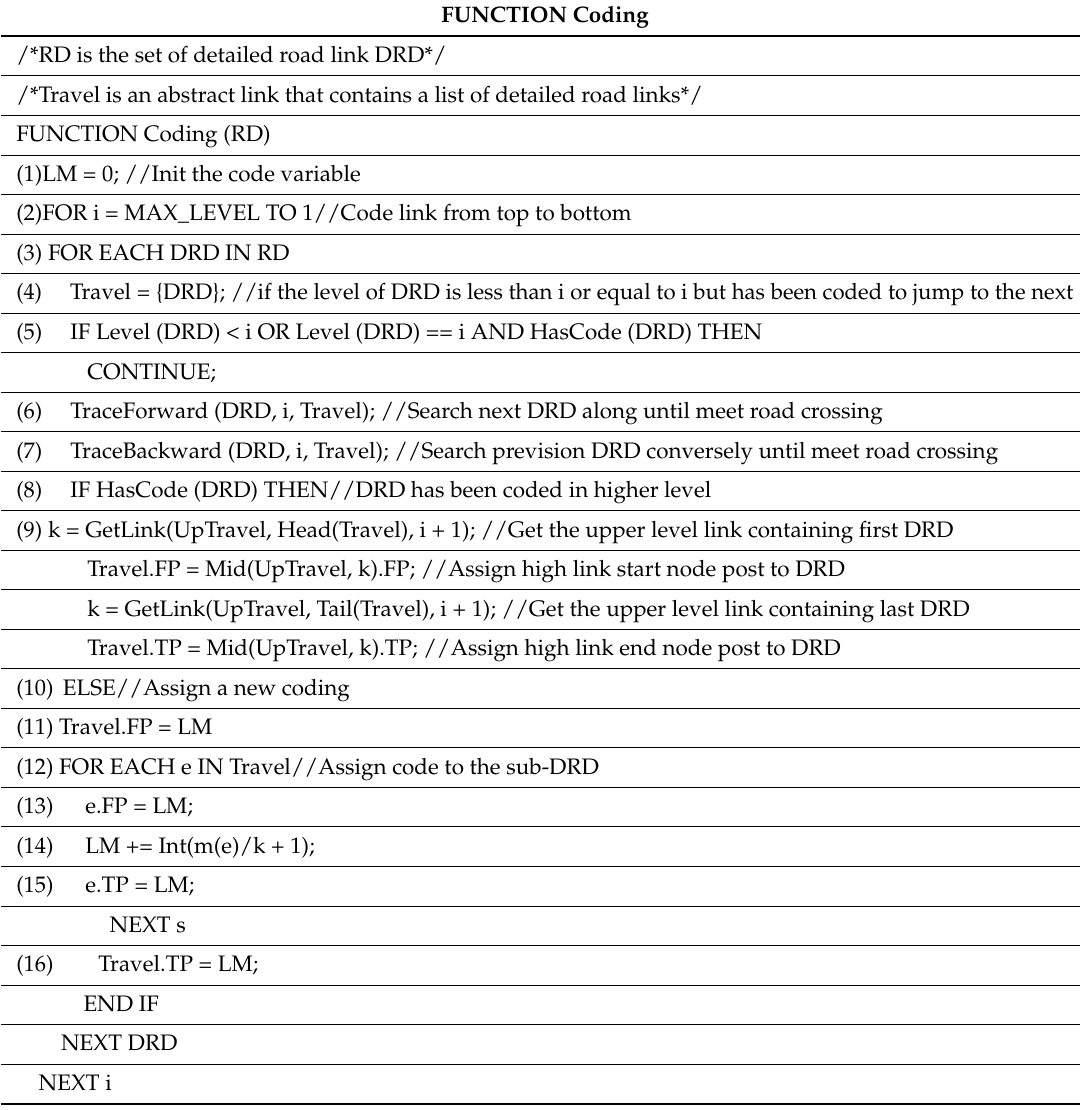
Table T1. Pseudo Code of the Hierarchal Linear Link Coding (LLC) Algorithm. FUNCTION